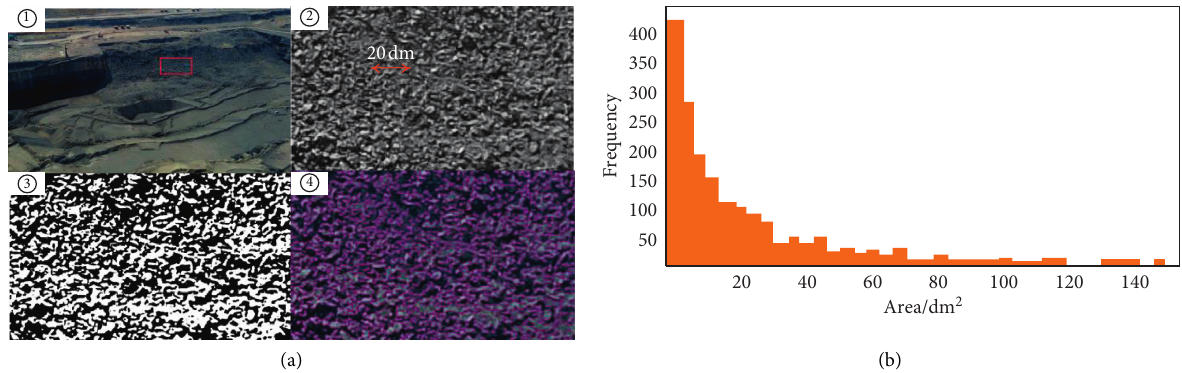
Figure 5: Analysis and processing results of fragmentation distribution. (a) Image processing. (b) Size